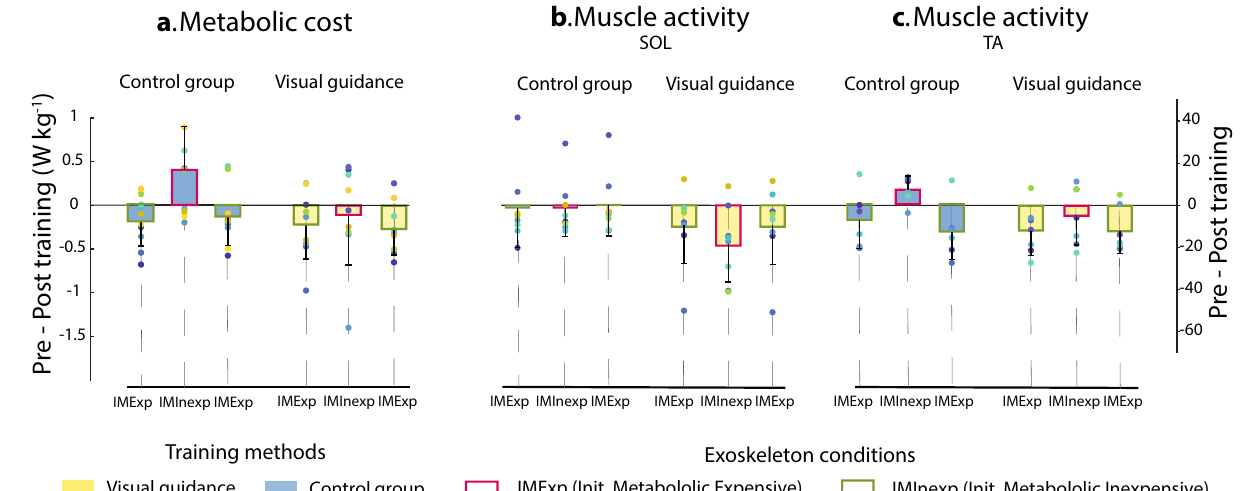
Figure 3. The change in ( a ) metabolic cost, ( b ) soleus and ( c ) tibialis anterior activation levels after training, compared to the pre-training (Pre-Post training). Each bar represents the mean of the difference in normalized pre-training and post-training outcomes for the training methods (Visual guidance (yellow), Control group (blue)) and the exoskeleton conditions (initially metabolic expensive (IMExp, red outline), and initially metabolic inexpensive (IMInexp, olive outline)). Error bars indicate standard deviation. Colored dots shows the individual responses for each